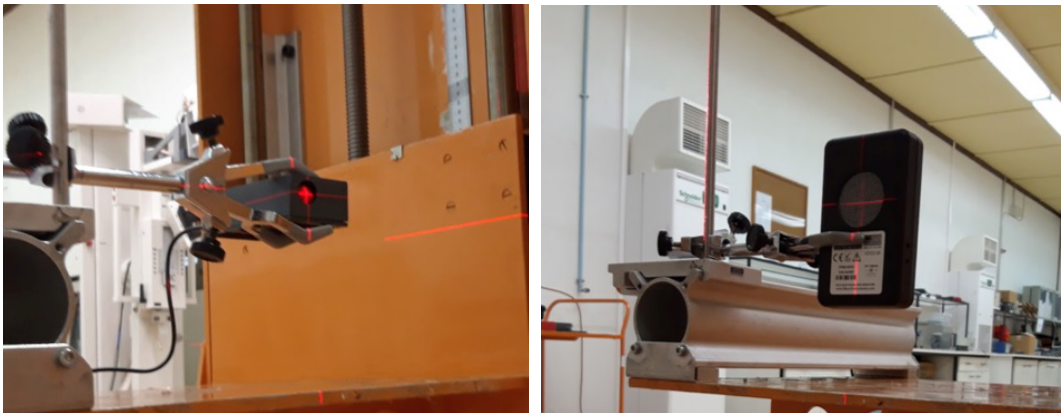
Figure 4. Acquisition setup for the Sparkfun ( left ) and the Mazur ( right ) verification procedure. The geometric center of the sensitive volume of each GMC was aligned with the source geometric center using vertical and horizontal